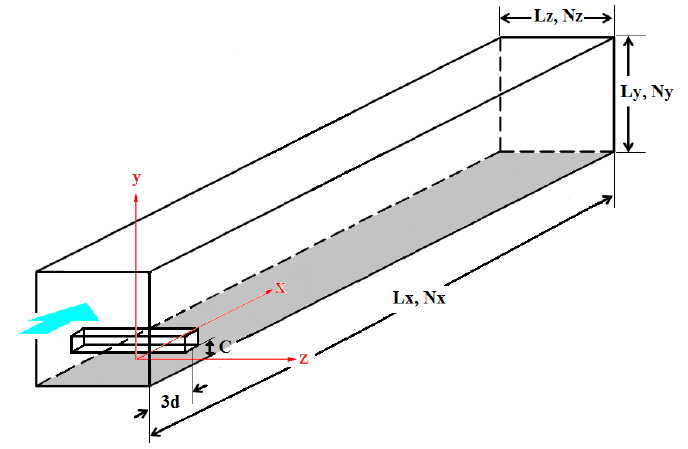
Fig. 1 Schematic of the computational domain Table 1 Computational domain size and mesh